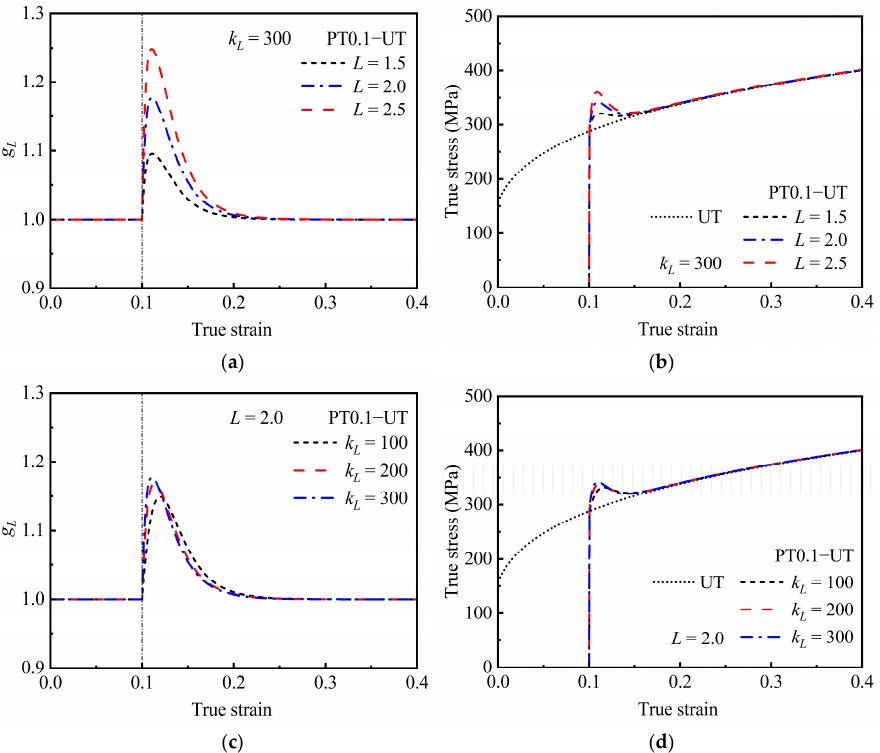
Figure 11. Predicted responses of latent hardening effect during cross loading of PT0.1 − UT; evalua- tion of g L under ( a ) different L and ( c ) different k L ; and stress–strain curves under ( b ) different L and ( d ) different k L .